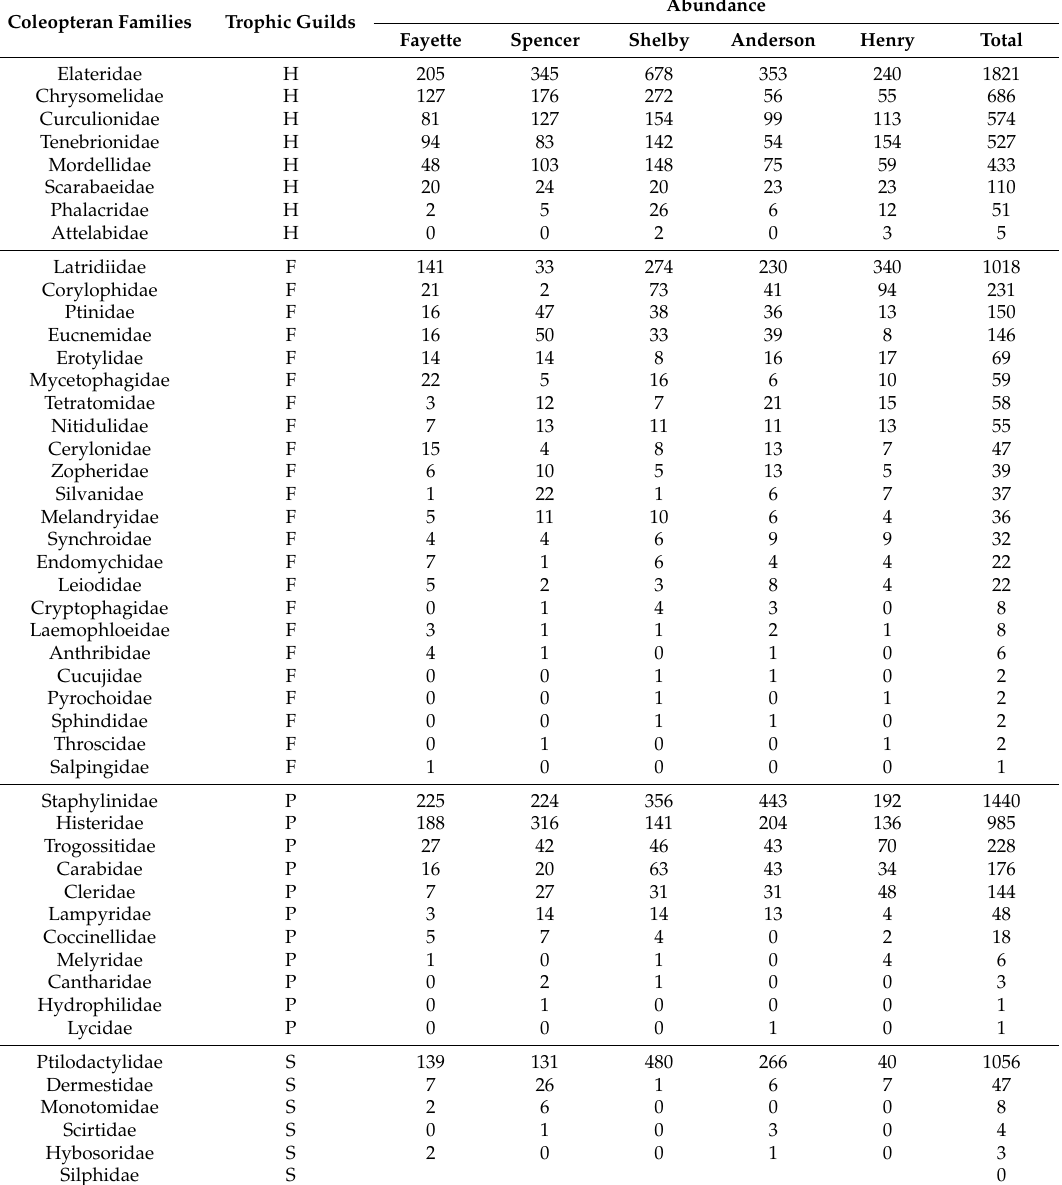
Table A1. Coleopteran family abundance at five forested sites in north central Kentucky with trophic guild designations including; herbivores (H), fungivores (F), predators (P), saprophages (S), xylophages (X), and parasitoids